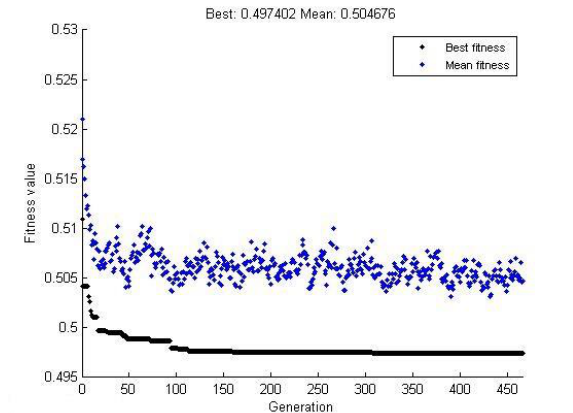
Figure 3: Fitness values achieved by the proposed